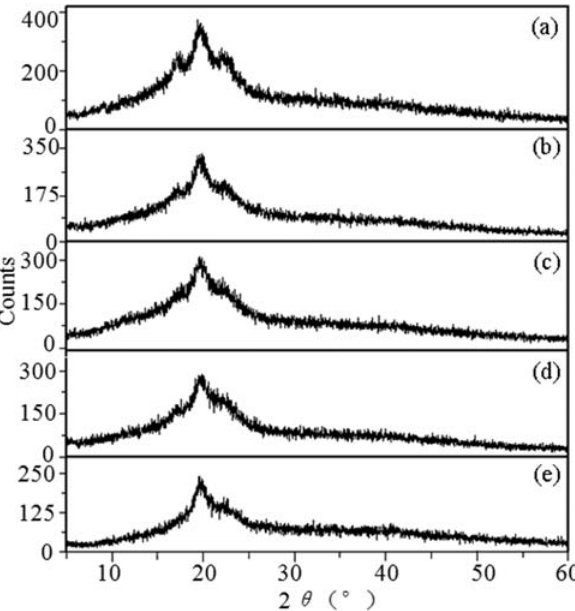
Figure 2: XRD patterns of starch/PVA/glycerol composite fi lms ( a ) , composite fi lm containing 5 wt% of ε - polylysine ( b ) , 10 wt% of ε - polylysine ( c ) , 15 wt% of ε - polylysine ( d ) and 20 wt% of ε - polylysine ( e )